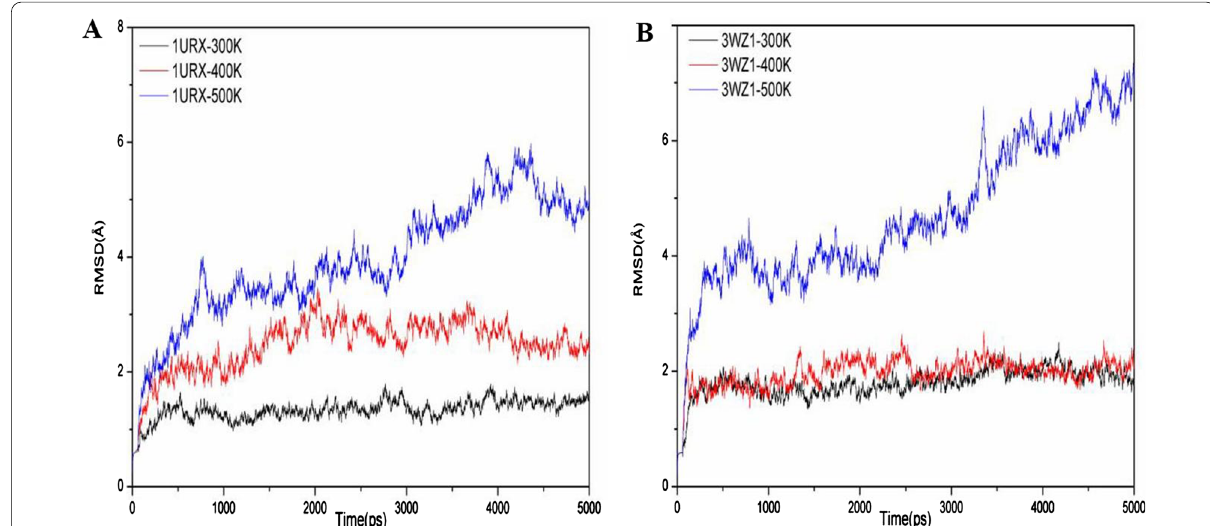
Fig. 2 Backbone RMS deviation values of ( A ) 1URX and ( B ) 3WZ1 at different temperatures as a function of time. The duration of each simulation is 5 ns